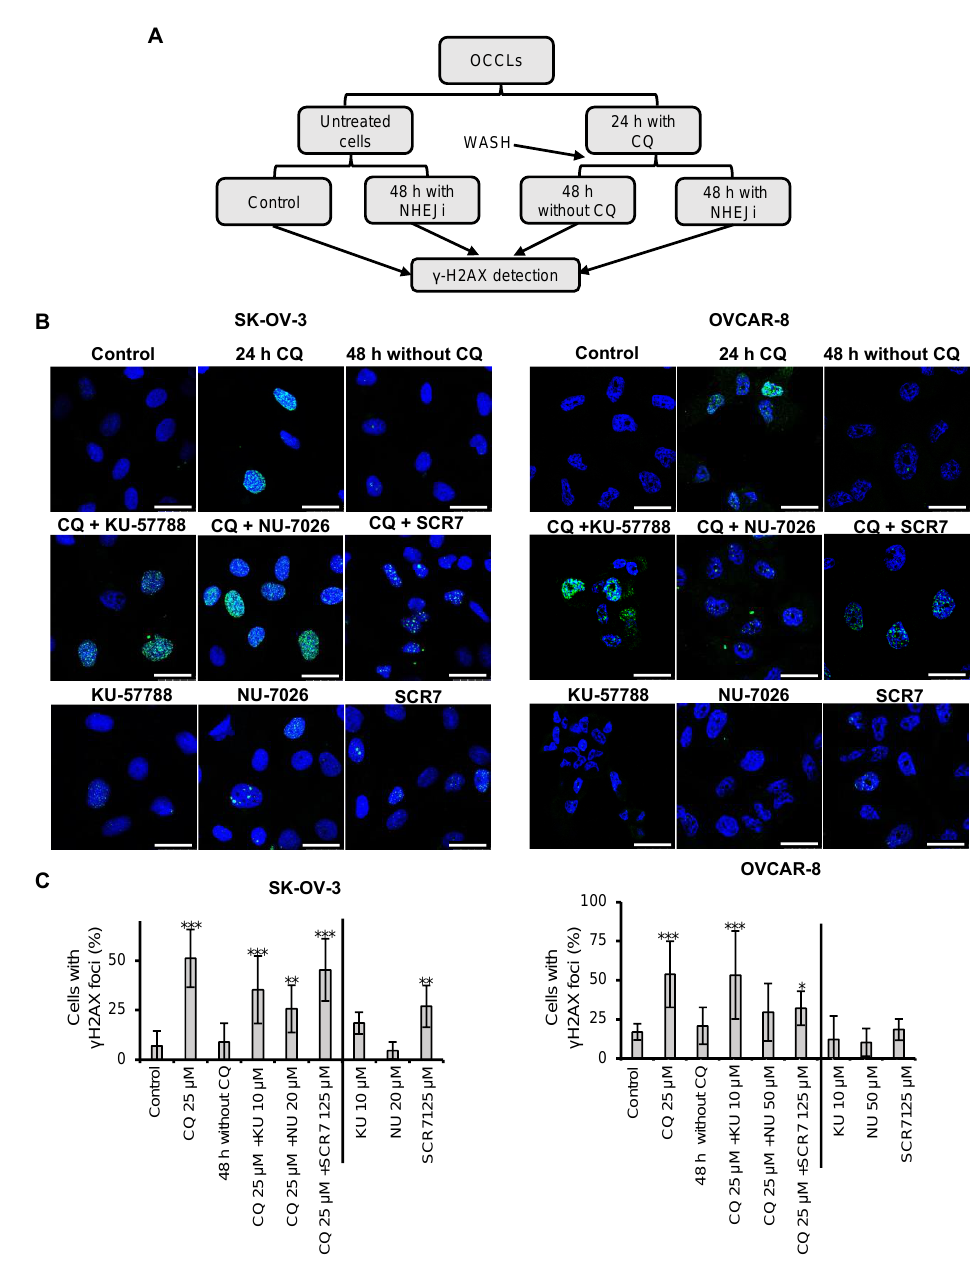
Figure 2. Effect of NHEJ inhibitors in the repair of DSBs generated by chloroquine. ( A ) Scheme of the experiment. OCCLs were treated for 24 h with 25 µM of CQ. Then, CQ was removed by washing, and cells were treated or not with NHEJi for 48 h. Part of the cells were left untreated or treated only with NHEJi. ( B ) Representative immunofluorescence microscopy images of OCCLs treated with the indicated conditions and stained with DAPI (blue) and anti- γH2AX (green) to visualize DNA DSBs. Scale bar: 25 µM. ( C ) Percentage of cells exhibiting γH2AX foci (>5 foci/cell) in the presence of CQ, NHEJi, or both. A minimum of 50 cells per condition were analyzed in three independent experiments. Error bars represent the SD (*** p < 0.001; ** p < 0.01; * p < 0.05, compared to CQ-treated cells 48 h after CQ removal).